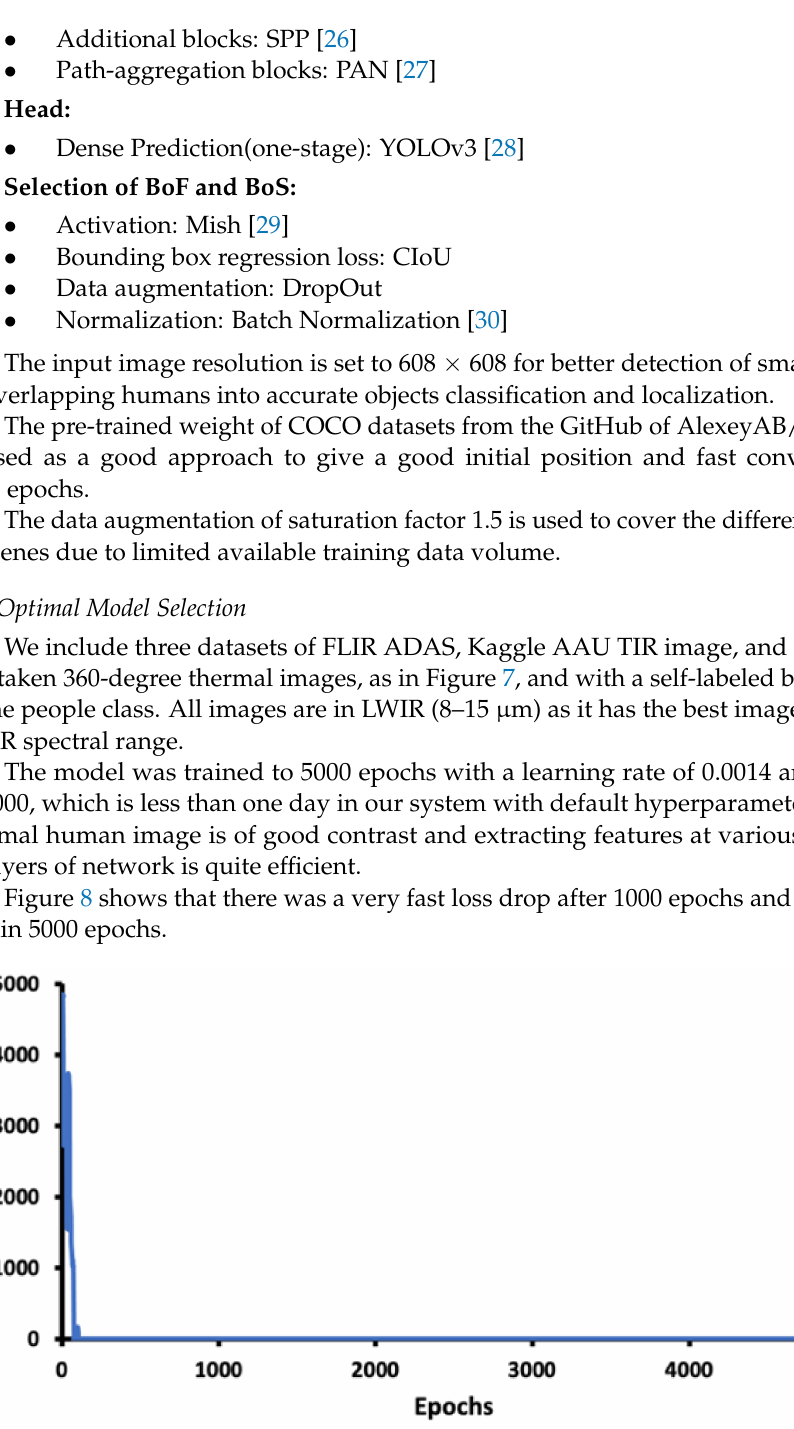
Figure 8. Training loss in